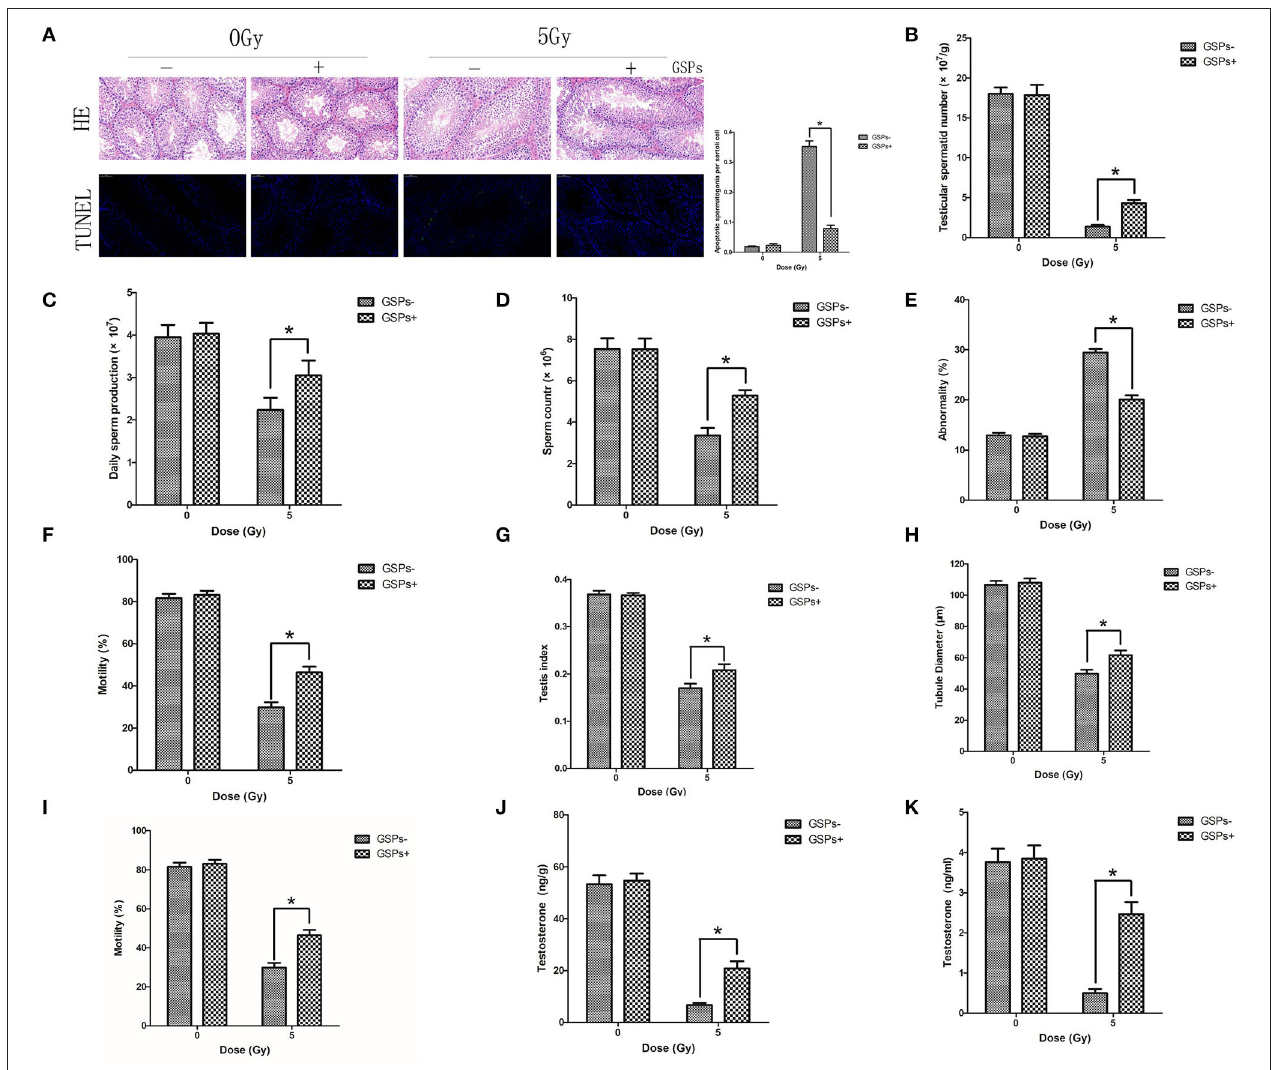
FIGURE 3 | GSPs have radioprotective effects on the testes. (A) Hematoxylin-eosin (HE) and TdT-mediated dUTP Nick-End Labeling (TUNEL) staining of testes dissected 24h after 5Gy IR of the lower abdomen. HE staining shows no abnormality of sperm is found. TUNEL-positive cells only exist in spermatogonia. Quantitative analysis result shows that TUNEL-positive cells of the IR + GSPs group are significantly lower than those of the IR group. (B) The sperm head counts, 29 days post-IR, of the IR + GSPs group are significantly higher than those of the IR group. (C) The daily sperm production, 56 days post-IR, of the IR + GSPs group is significantly higher than that of the IR group. The sperm count (D) and mobility rate (E) of epididymis, 56 days post-IR, of the IR + GSPs group are significantly higher than those of the IR group, and the abnormality rate (F) is significantly lower than that of the IR group. (G) The testicular organ index (weight of both testes/weight of mouse), 29 days post-IR, of the IR + GSPs group is significantly higher than that of the IR group. (H) The diameter of the seminiferous tubules, 29 days post-IR, is significantly reduced, while GSPs alleviate this change. (I) The testicular tubule differentiation index (percentage of differentiated tubules), 56 days post-IR, of the IR + GSPs group is significantly higher than that of the IR group. ELISA assay shows that GSPs significantly alleviate the IR-induced decrease of the testosterone content in mouse testis (J) and serum (K) . Data are presented as mean ± SD ( n = 6). * P <